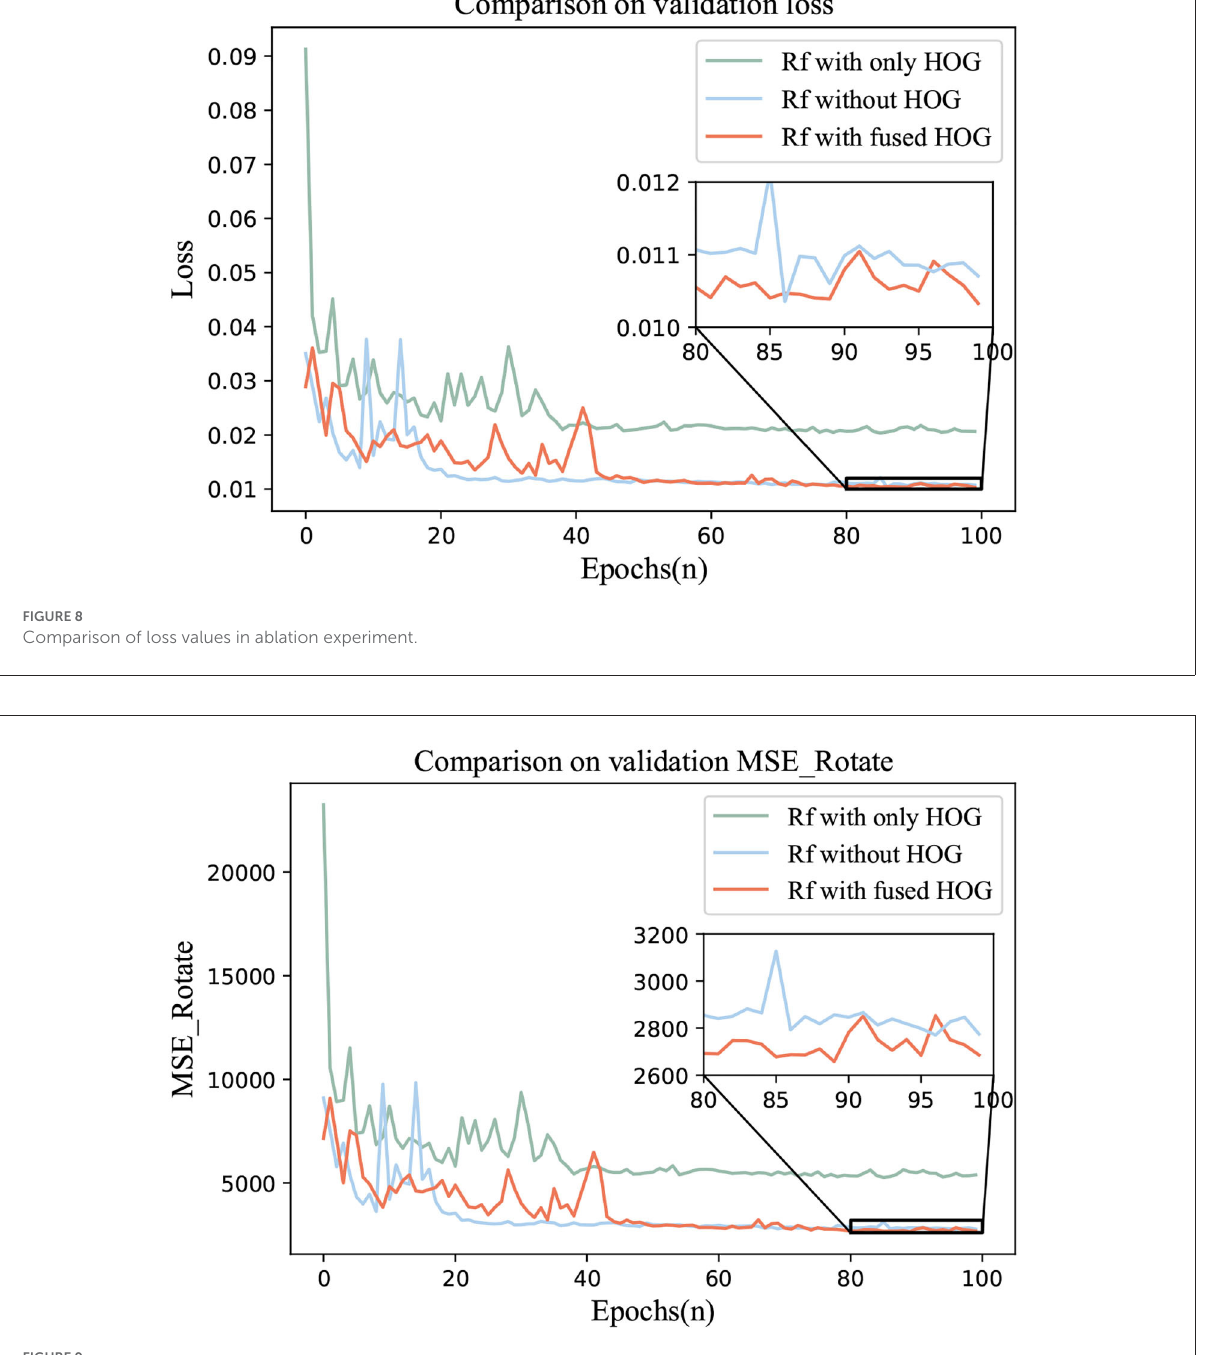
only HOG features for training. The second was without the HOG feature. The third one was Rf with fused HOG.